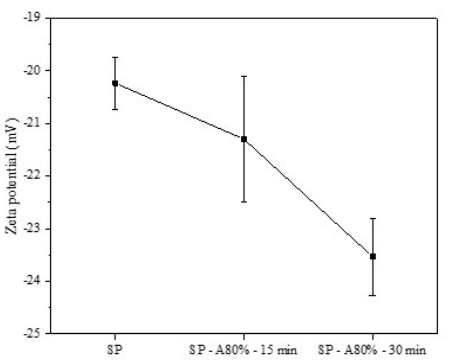
Figure 5. Zeta potential of SP, SP – A80% - 15 min, and SP – A80% - 30 min aqueous